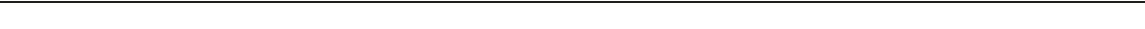
Fig. 7 A signal peptide switch mutant of PspC1 affects its surface distribution and immunoprotective function. a Schematic presentation of the signal peptide exchange mutant of PspC1 (left panel) and amino acid sequences of the signal peptide of PspC1 and PspC2 (right panel). Arrows represent the signal peptide cleavage site. b Representative STED images of the PspC1 distribution in the signal peptide mutant, BHN418 sp2pspC1 , and in wt BHN 418 bacteria. PspC1 is stained using anti-PspC1 serum and Atto674-N secondary antibody. c The fl uorescence intensity distribution pattern along the length of bacteria was analyzed using a MATLAB based script. The x -axis represents the individual bacteria with length increasing from left. The y -axis shows the actual length of bacteria (in µ m) and the color map represents the fl uorescence intensity along the bacteria (with color scale from black via red to yellow for the highest intensities). b , c Scale bar = 1 µ m. d Western blot analysis showing the expression level of PspC1 and PspC2 in wt BHN418 and in the signal peptide switch mutant, BHN418 sp2pspC1 . GAPDH was used as a loading control. Full blots are shown in Supplementary Fig. 23. e Representative histogram of FH binding to wt BHN418 and to the signal peptide switch mutant, BHN418 sp2pspC1 . FH binding was detected using a polyclonal goat anti-FH antibody and a FITC-labeled rabbit anti-goat IgG secondary antibody. Bacteria incubated without FH were used as control. f Representative histogram of C3 and C5b-9 deposition on BHN418 and on the signal peptide switch mutant, BHN418 sp2pspC1 , after incubation with 20% normal human serum. Bacteria were sequentially stained with goat anti-C3 or mouse anti C5b-9 antibody followed by FITC-labeled secondary antibody. g Uptake of wt BHN418 or its isogenic signal peptide switch mutant, BHN418 sp2pspC1 , by THP-1 derived macrophages in the presence of human serum. Graph shows Mean ± SEM of three independent experiments. * = p < 0.05. e , f Representative histogram of three independent